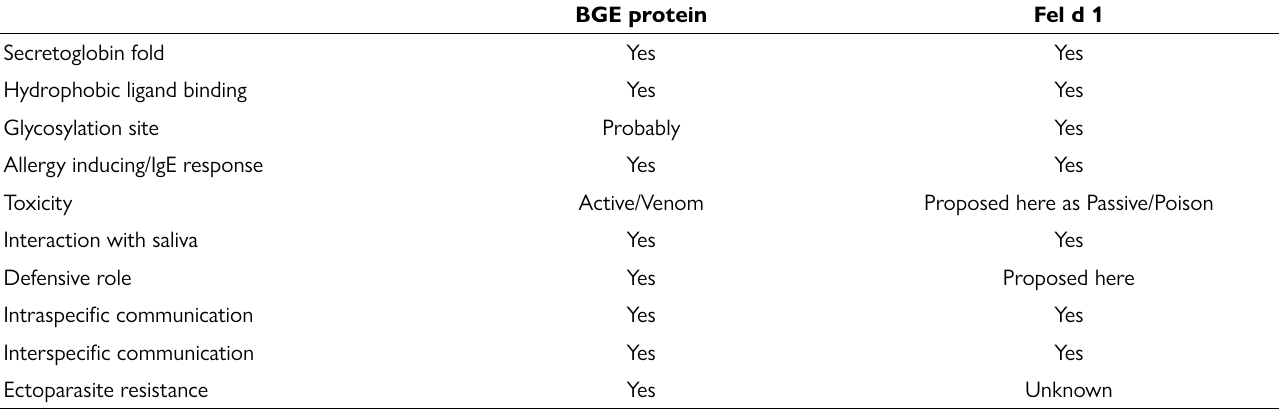
Table 1. Comparison between slow loris BGE protein and domestic cat Fel d